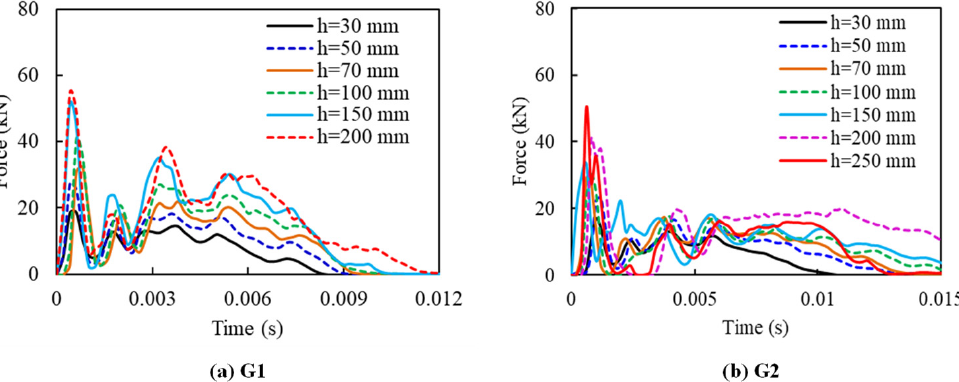
Figure 8. Impact force-time histories of G1 and G2.